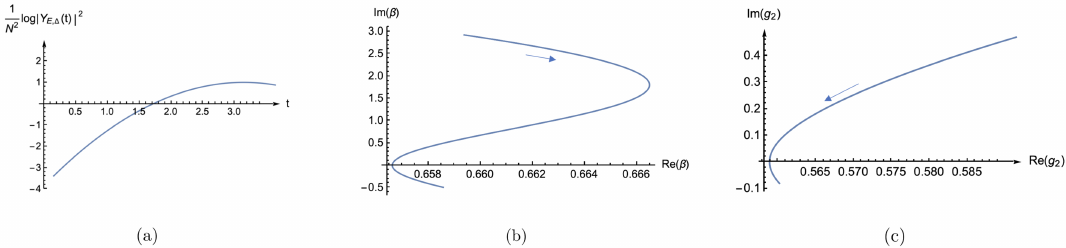
Figure 17 . The numerical solutions to (A.7) with E = 0 . 6 N 2 , ∆ 2 = 0 . 5 N 2 . In (b), (c) we used the arrows to show which directions the curves are running with time. g 1 is exactly zero in the